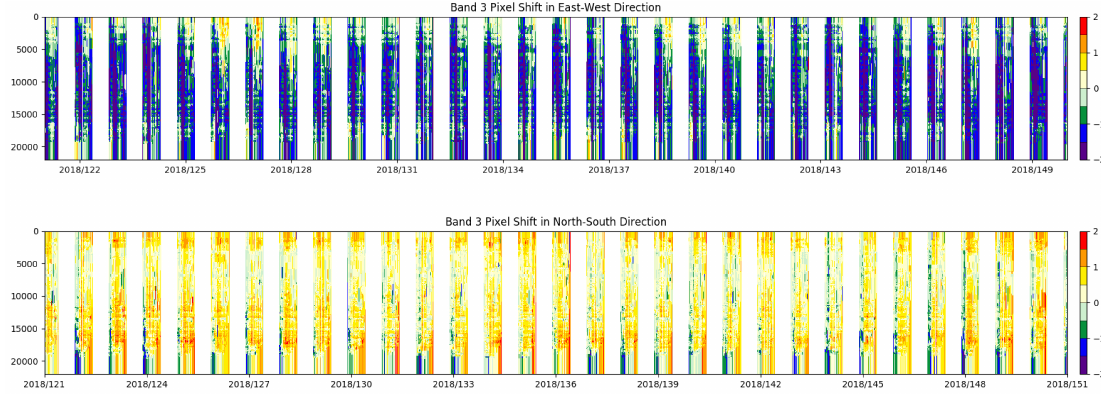
Figure 8. Same as Figure 6, but for Himawari-8 AHI from 1 May 2018, 00:00 UTC to 2018/05/01, 23:50 UTC, with a 10 min time